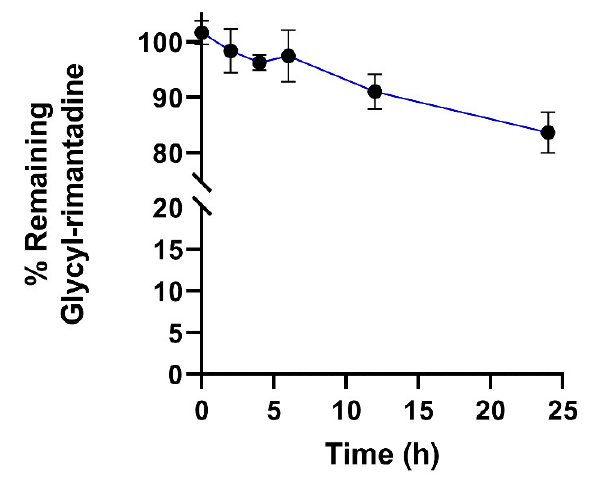
Figure 6. Stability of glycyl-rimantadine ( 4b ) after incubation in human plasma at 37 ◦ C for 24 h. The % remaining amount of glycyl-rimantadine ( 4b ) is the estimated concentration after 0, 2, 4, 6, 12 and 24 h in respect to the initial concentration of the conjugate. Each data point represents the average of three replicates ± SD.